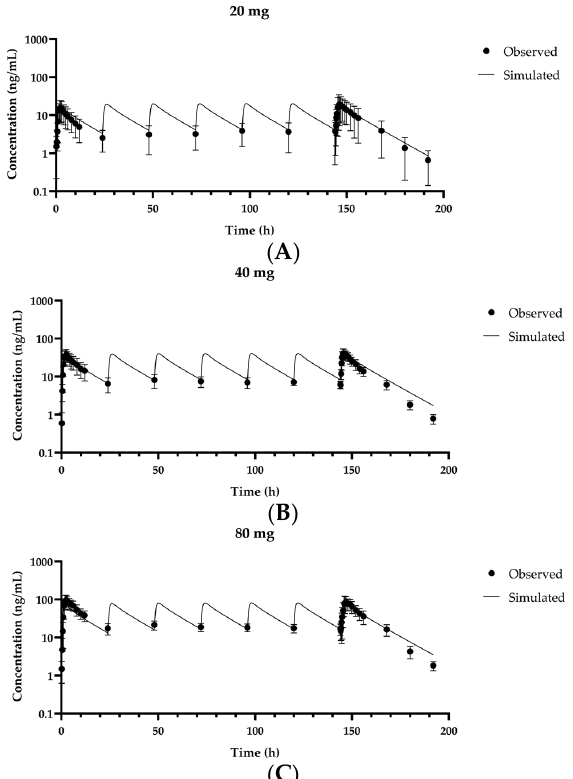
Figure 3. Observed and predicted fexuprazan concentrations at repeated doses of 20 mg/day ( A ), 40 mg/day ( B ), and 80 mg/day ( C ) administered to humans for 7 days. Solid lines represent simulated results of optimized model or model prediction. Closed circles (●) represent observed data [10,22] . Data are means ± SD for eight healthy volunteers.